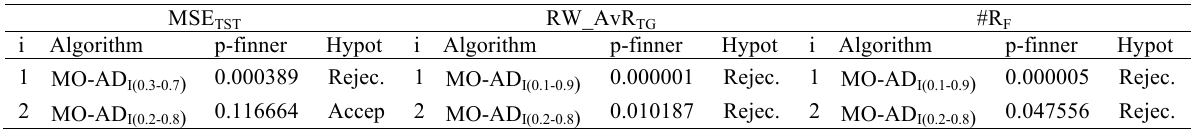
Table A.10 Finner Table with α = 0.05 for the methods on MSE TST , R W _AvR TG and #R F measures on MAX INT point using